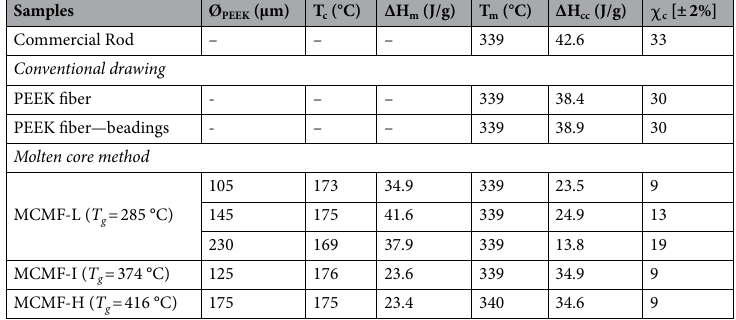
Table 4. Diameter of the PEEK structure (Ø PEEK ) in the considered MCM sample, cooling rates during the drawing, thermal transitions (T g , T c , T m ), enthalpy of cold crystallization (ΔH cc ), enthalpy of melting (ΔH m ) and degree of crystallinity ( χ c ) of bulk and fibered PEEK samples.